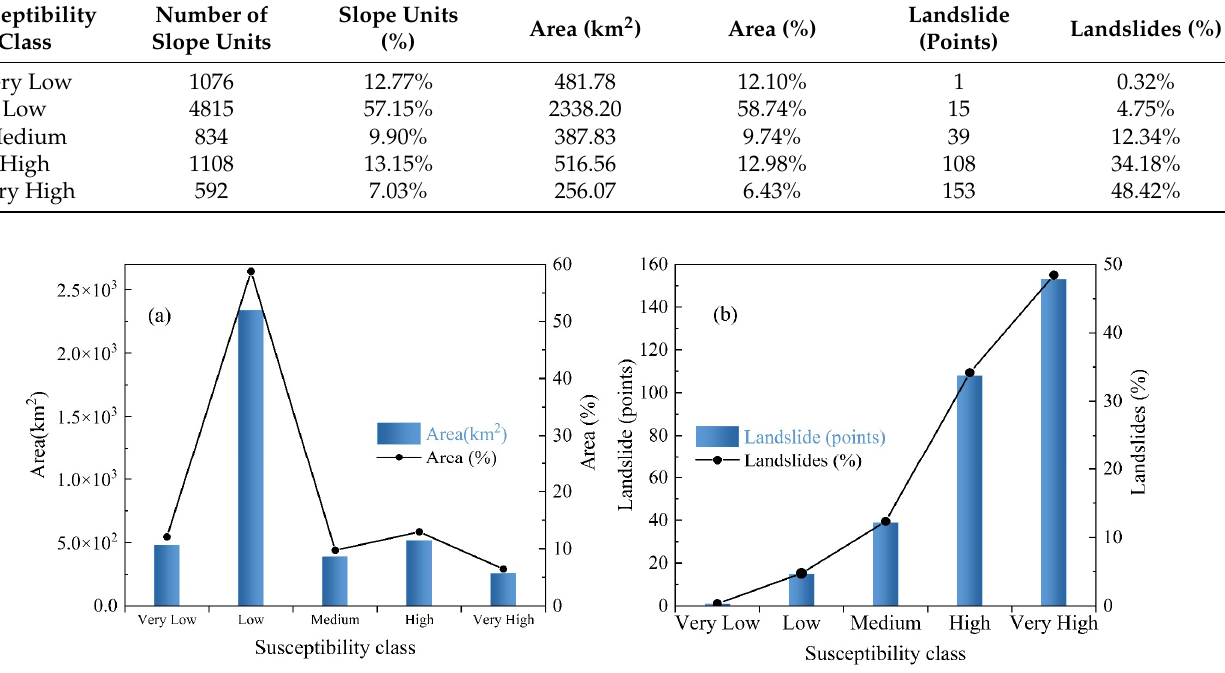
Figure 11. Quantitative analysis of the susceptibility maps: ( a ) distribution of susceptibility classes; ( b ) frequency ratio of landslides in each susceptibility class.